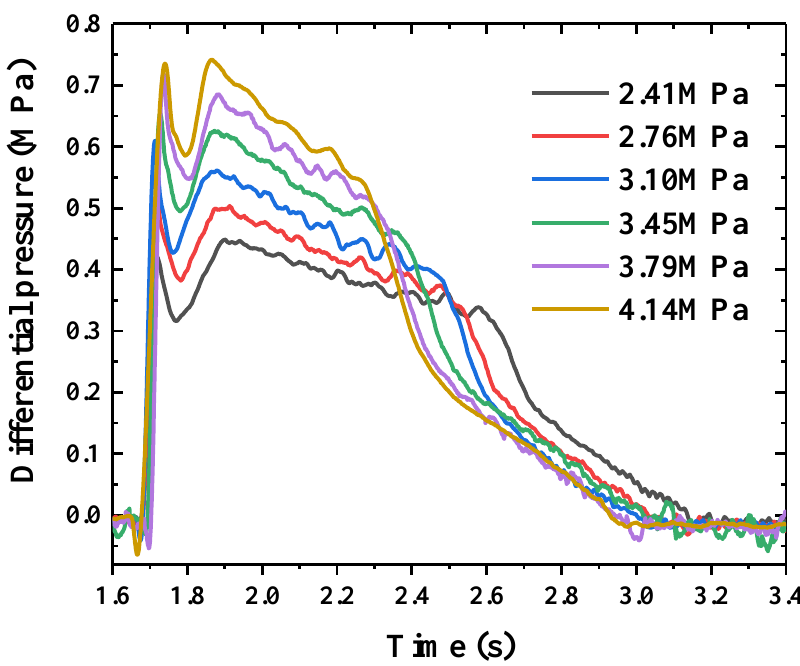
Figure 7. The differential pressure of HFC-125 under different release pressures.